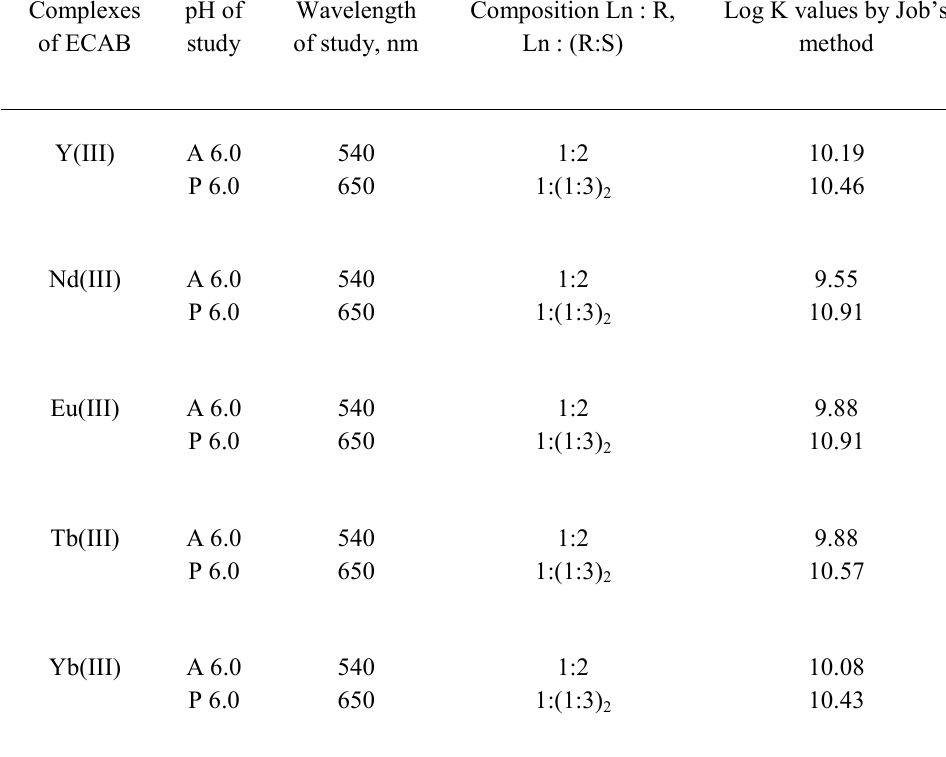
Table 4. Composition and log K values of lanthanide complexes of ECAB in absence and presence of